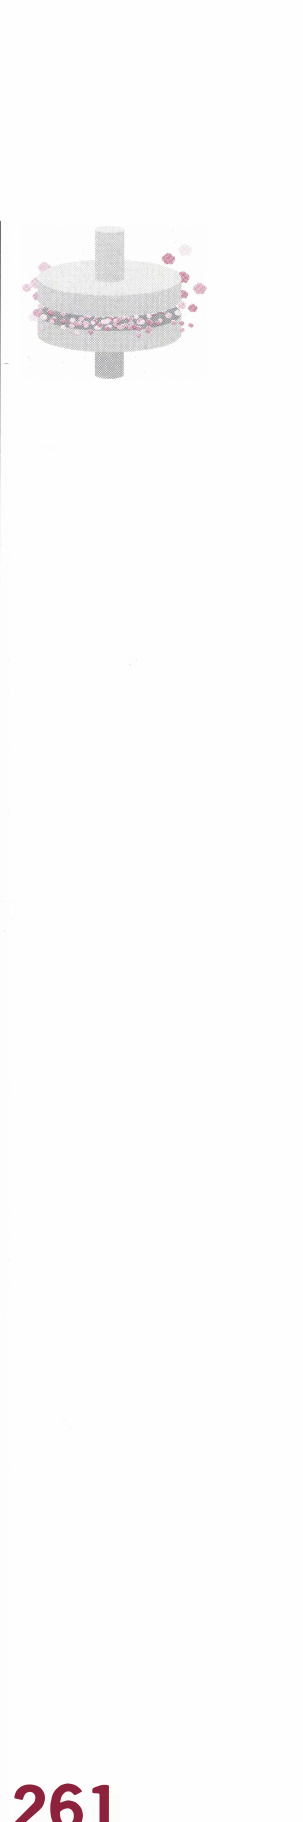
Fig. 6: Influence of the degree of